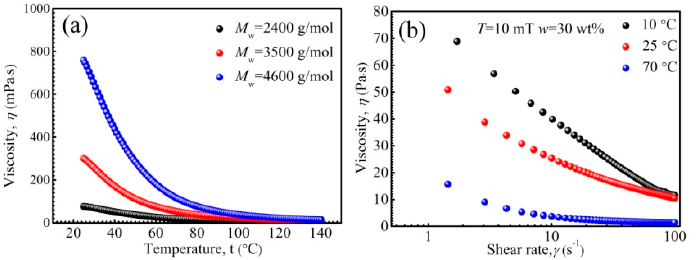
Figure 6. The viscosity of ferrofluids as a function of temperature ( a ), the viscosity of ferrofluids as a function of shear rate ( b ).